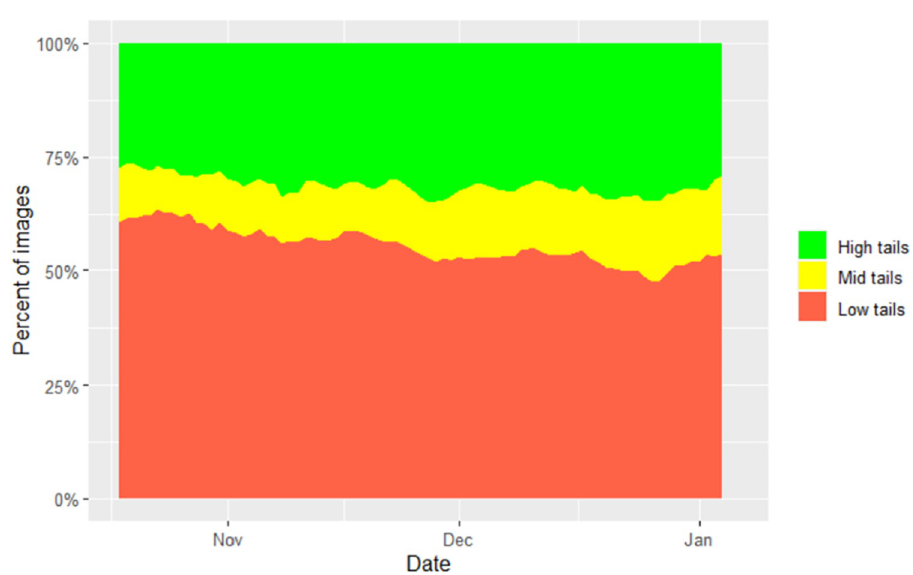
Fig 7. Example of tail posture data for a typical batch- stacked bar graph of proportion of low (red), mid (yellow) and high (green) tails by day.